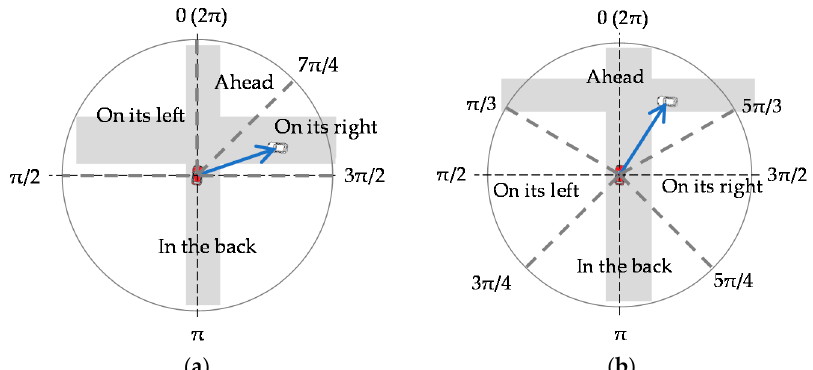
Figure 2. Determining the relative position of the communicating vehicle. The red vehicle is the own vehicle and the white vehicle is the other vehicle. ( a ) The own vehicle is the requesting vehicle; ( b ) the own vehicle is the responding vehicle.